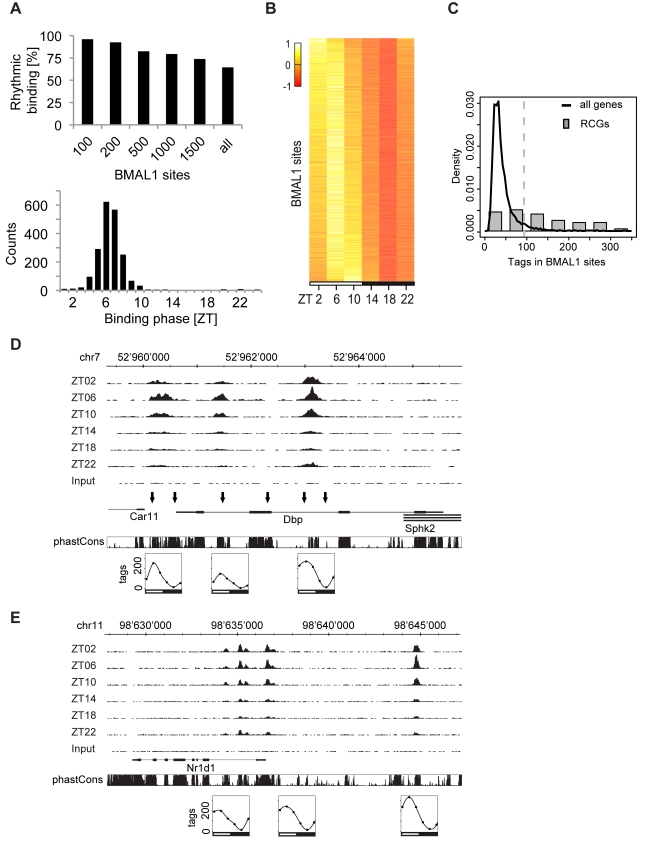
Time-resolved BMAL1 ChIP-Seq in mouse liver.(A) Top panel: Fraction of rhythmic BMAL1 sites in different subgroups. Sites were ranked according to binding strength using total number of tags over all the time points. Subgroups include all sites up to the indicated ranking. Lower panel: Histogram of binding phases peaks between ZT4 and ZT8. (B) Temporal profiles of BMAL1 binding ordered by phase. Only rhythmic profiles are plotted (Fisher test, p<0.05; see Materials and Methods). (C) Histogram of number of tags in BMAL1 binding sites for all sites (black curve) and a group of RCGs (grey bars), 63% of which (26 out of 41) are above the 95% quantile shown by the vertical dashed line. The RCGs include Per1/2/3, Cry1/2, Dec1/2, Rev-Erbα/β, Rorα/γ, E4bp4, and Hlf/Tef/Dbp, and show 41 binding sites all together. (D) BMAL1 ChIP-Seq data at the Dbp locus (visualized in the UCSC Genome Browser) show three rhythmic binding sites located at the promoter, in the first intron, and in the second intron. Notably, these overlap with DNase I hypersensitive sites [28], shown by the black arrows. The panels below show quantifications of BMAL1 binding. The scale is in number of non-redundant tags per 10 million mapped tags (see Materials and Methods). The PhastCons conservation score measures phylogenetic conservation among 20 placental mammals [85]. (E) UCSC Genome Browser view of BMAL1 ChIP-Seq data at the Rev-Erbα locus, showing two circadian binding sites close to its promoter and one upstream (−8 kb) site.